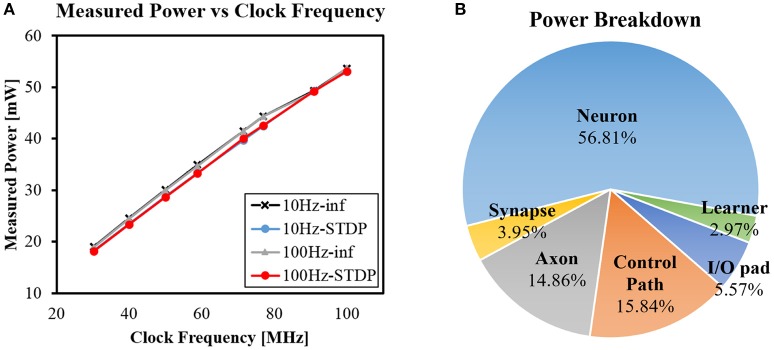
(A) Measured power with different clock frequencies and (B) Power breakdown by functional module.